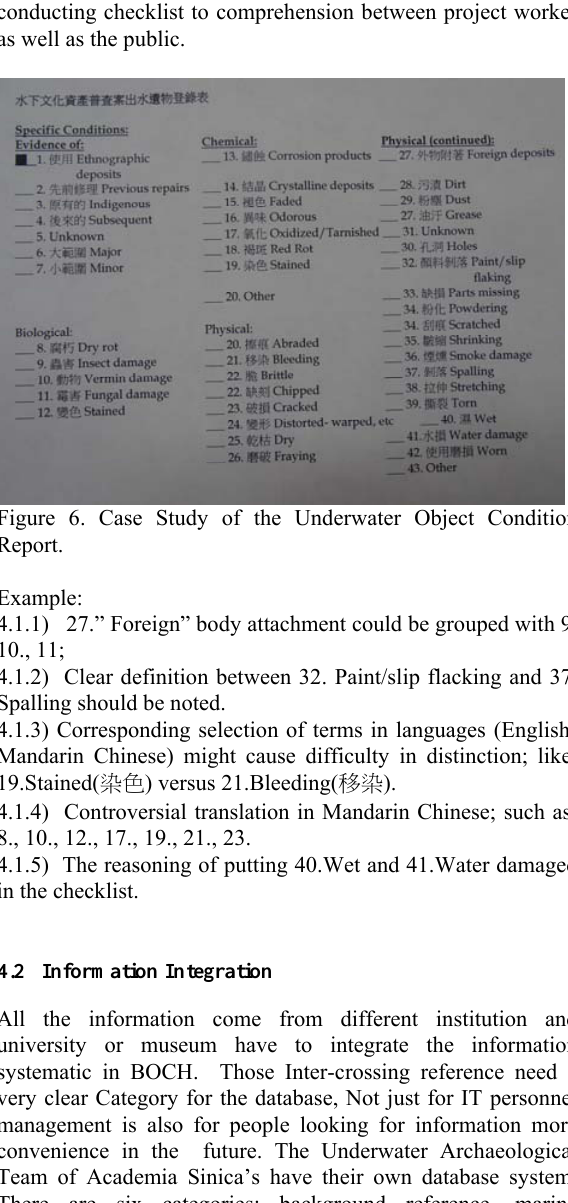
Figure 5. Research Method